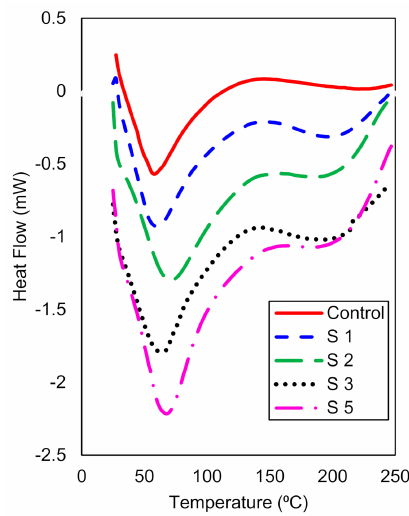
Figure 10. Differential scanning calorimetry (DSC) curves for control sample and some treated samples (S1, S2, S3 and S5; same codes as in Table